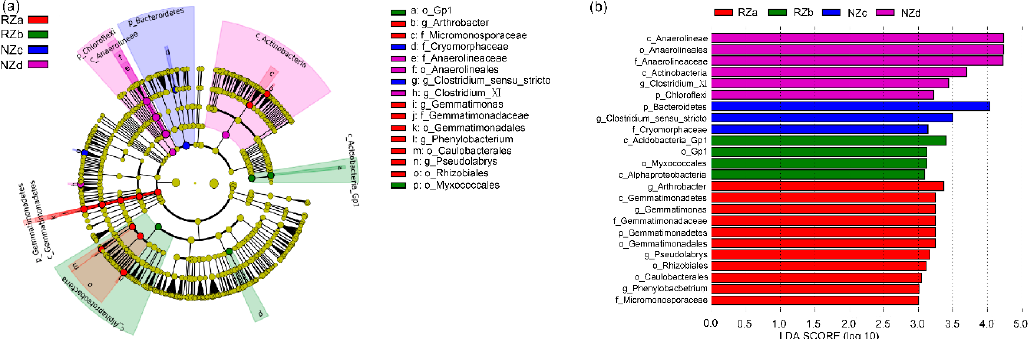
Figure 2. Heat map depicting the relative abundance of dominant OTUs (average relative abundance >0.2%) in the different sampling sites. The relative abundance dates were normalization and clusters were generated using Euclidean distance in R. Abbreviations: P. australis zone (RZ); non- P. australis zone (NZ); supralittoral zone with P. australis (RZa); eulittoral zone with P. australis (RZb); eulittoral zone without P. australis (NZc); infralittoral zone without P. australis (NZd).